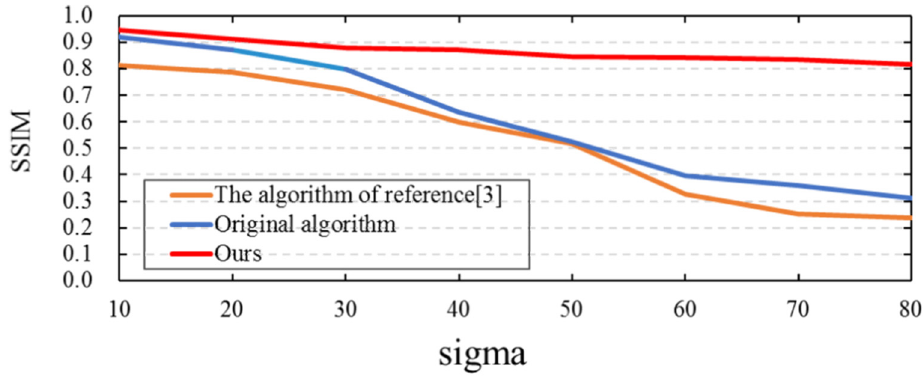
Figure 4. SSIM line chart of the three algorithms for the Cameraman image.